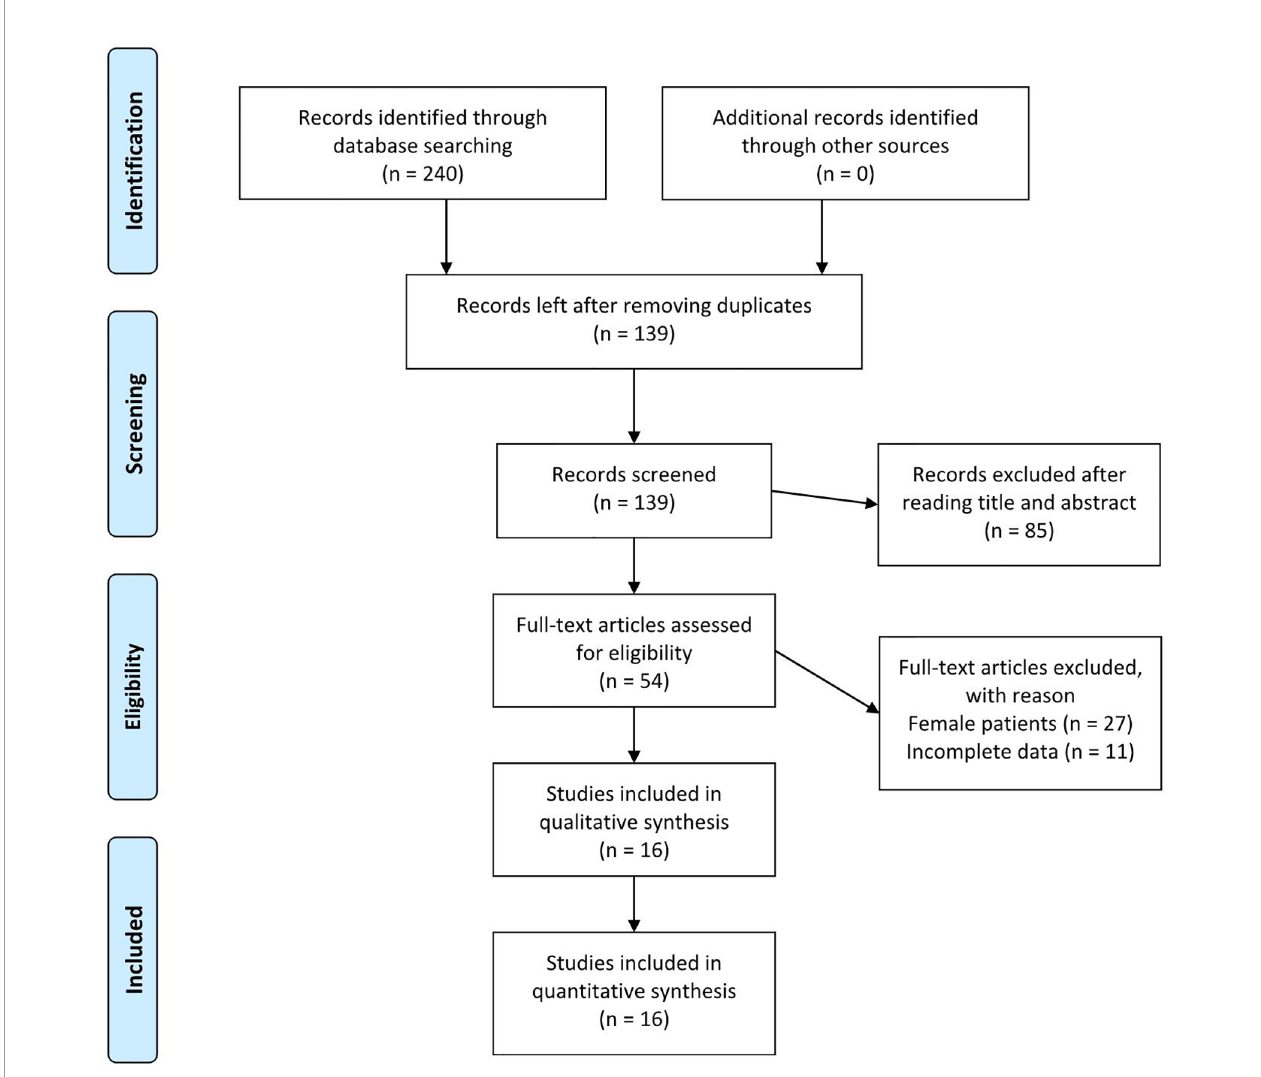
FIGURE 1 | PRISMA fl ow chart of the literature search